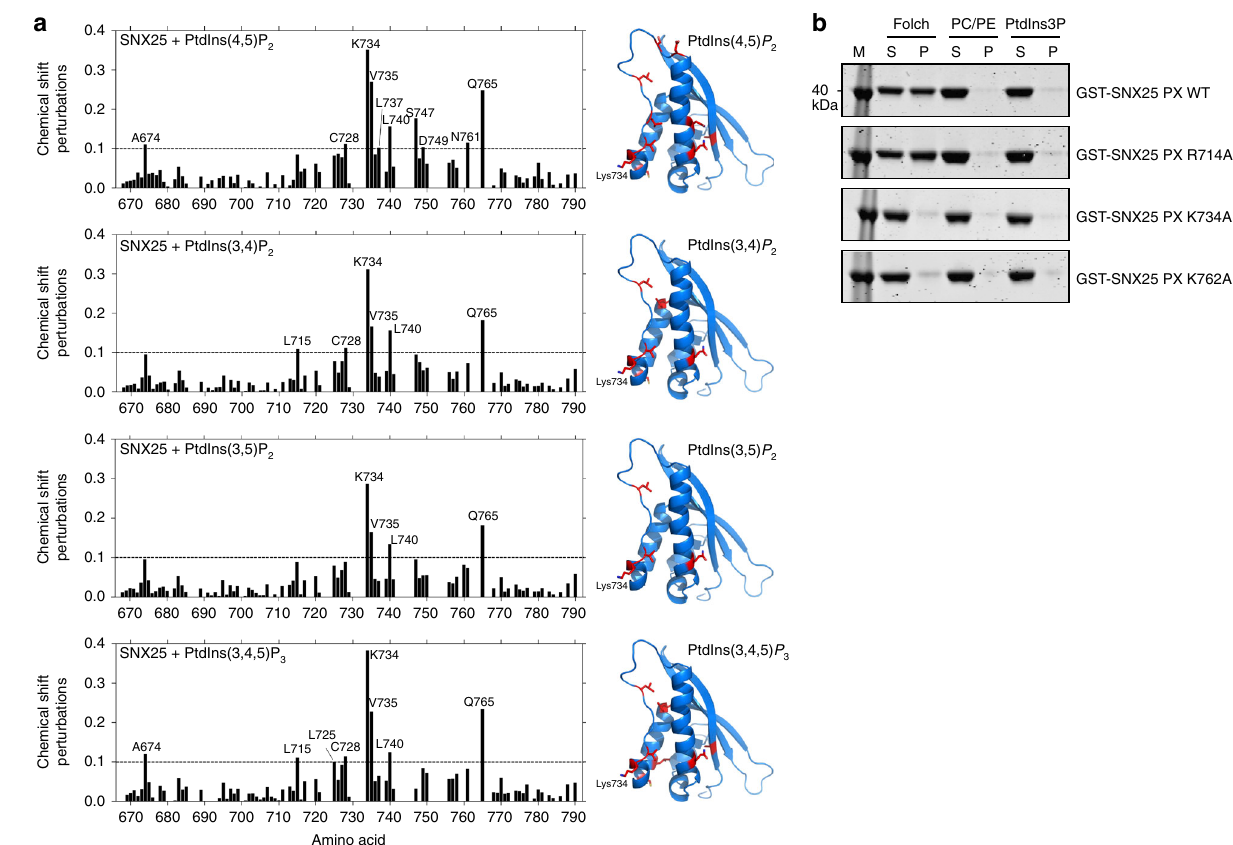
Fig. 5 Binding of SNX25 to phosphoinositides by NMR. a Plot of the average chemical shift changes in the 2D 1 H- 15 N-HSQC spectra of the SNX25 PX domain upon addition of the indicated phosphoinositides. The SNX25 PX domain is shown in ribbon representation, with residues showing the greatest chemical shift changes The residues displaying signi fi cant chemical-shift changes on addition of the indicated phosphoinositides colored in red ( Δ δ > 0.1 ppm; Δ δ = [(0.17 Δ NH) 2 + ( Δ HN) 2 ] 1/2 ) 45 . b Liposome pelleting assay for GST-SNX25 PX domain and mutants. GST-tagged PX domains were incubated with the indicated arti fi cial liposomes, subject to ultracentrifugation, and the pellet ‘ P ’ and supernatant ‘ S ’ fractions analyzed by SDS-PAGE and Coomassie GST-tagged SNX13, SNX14, SNX19, and SNX25 proteins, the same procedure was scaling in the CCP4 suite 38 . SNX23, SGK3, and SNX32-IncE were solved by used, but the thrombin cleavage step was omitted, and the proteins were eluted molecular replacement using PHASER 39 . The structure of SNX15 was solved using from glutathione – Sepharose with 20 mM glutathione in the elution buffer. single wavelength anamolous dispersion (SAD), and the phases were calculated using the peak wavelength data of Selenium with AUTOSOL using the PHENIX suite 40 . The solution from AUTOSOL was built using AUTOBUILD and the resulting model was rebuilt with COOT 41 followed by repeated re fi nement runs Crystal structure determination . The PX domain of SNX15, SNX23, and SGK3 and model building with PHENIX.re fi ne and COOT. Structure images were were gel- fi ltered into buffer containing 50 mM Tris (pH 8.0), 100mM NaCl, 2 mM prepared with PYMOL (pymol.org). DTT, and concentrated to 10 mg/ml for crystallization at 20 °C. The protein was supplemented with 10mM DTT before setting up hanging-drop crystallization screens using a mosquito liquid handling robot (TTP LabTech). SNX15 PX domain from one crystal was crystallized in 100 mM Tris (pH 8.5), 200 mM LiSO 4 , 24% PEG4000 and 10% glycerol. SNX15 PX domain from 2 crystals were crystallized in 4M NaCl, 0.1 Tris (pH 8.5), with the addition of 30 mM inositolhexakisphosphate (IP6). Despite the presence of IP6, no bound ligand was observed in the electron density. The SNX23 PX domain was crystallized in 50 mM Tris (pH 8.5), 200 mM NaCl, and 25% PEG3350. The SGK3 PX domain was crystallized in 100 mM sodium citrate and 2 M sodium malonate (pH 5.0). For crystallization of the SNX32 complex with IncE, the synthetic peptide used for protein crystallization was purchased from Genscript (USA) (IncE residues PANGPAVQFFKGKNG- SADQVILVTQ). For the crystallization set up, peptides were weighed and dis- solved in water to make a stock peptide concentration of 10mM. This was diluted down to 2x molar excess to the protein molar concentration. The SNX32 PX domain (12 mg/ml) was directly mixed with the IncE peptide at a 1:2 molar ratio of protein to peptide and incubated on ice for 1h. Ninety-six-well crystallization hanging-drop screens using commercial kits were set up using a Mosquito Liquid Handling robot (TTP LabTech) at 20 °C in the UQ ROCX facility. These plates were incubated at 20 °C in a Rockimager storage hotel (Formulatrix). Optimized Liposome preparation . All the phosphoinositides were protonated prior to usage. diffraction-quality crystals of SNX32-IncE were obtained using streak seeding in sitting drop vapor diffusion plates. The optimized crystallization condition was In brief, powdered lipids were resuspended in chloroform (CHCl 3 ) and dried under 20% PEG 8000, 0.1M TRIS (pH 8.0), 0.01 M MgCl 2 . argon. Dried lipids were then left in a desiccator for 1h to remove any remaining moisture. Dried lipids were resuspended in a mixture of CHCl 3 :methanol Data were collected at the Australian Synchrotron MX1 and MX2 Beamlines. iMOSFLM 36 was used to integrate the data, and AIMLESS 37 was used for data (MeOH):1 N hydrochloric acid in a 2:1:0.01 molar ratio, lipids were dried once